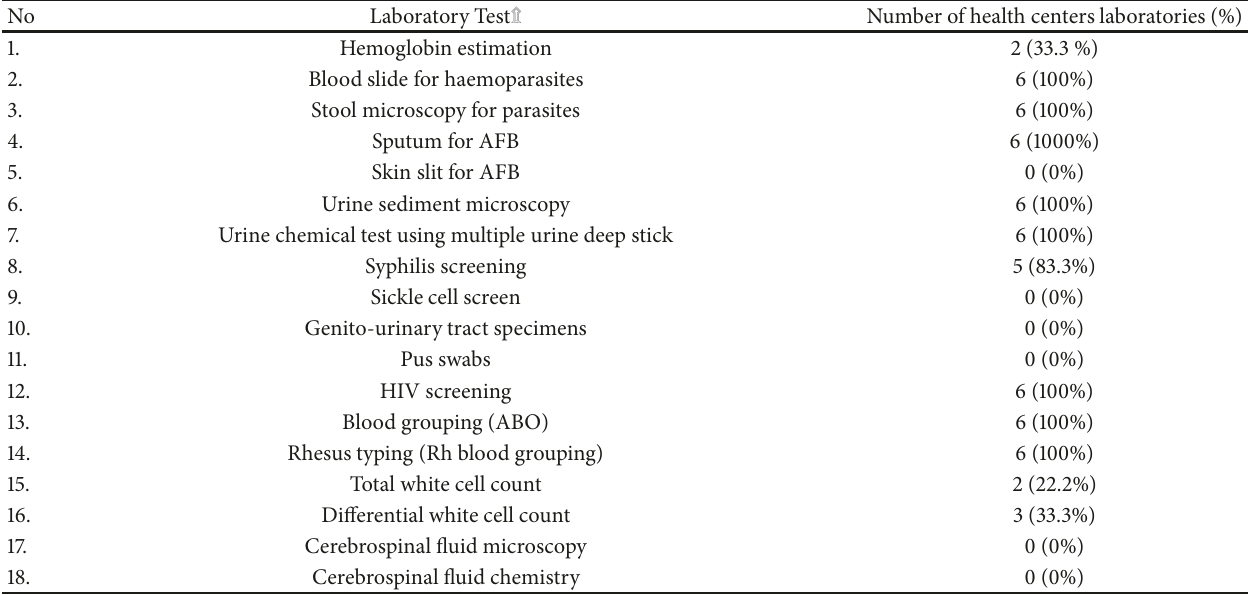
Table 2: Tests performed at six health centers laboratories of zone one of Afar region,